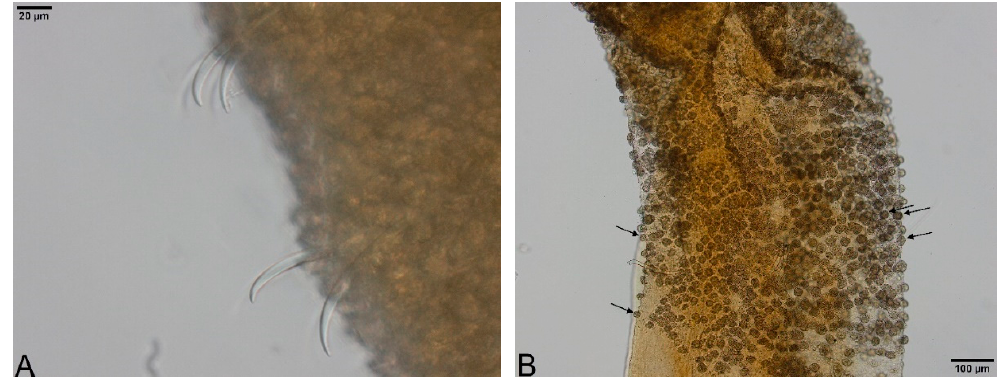
Figure 4. ( A ): Ventral chaetae of Embolocephalus velutinus . ( B ): Large dark and roundish particle aggregates of Spirosperma ferox (here, middle part). Author: Régis Vivien.